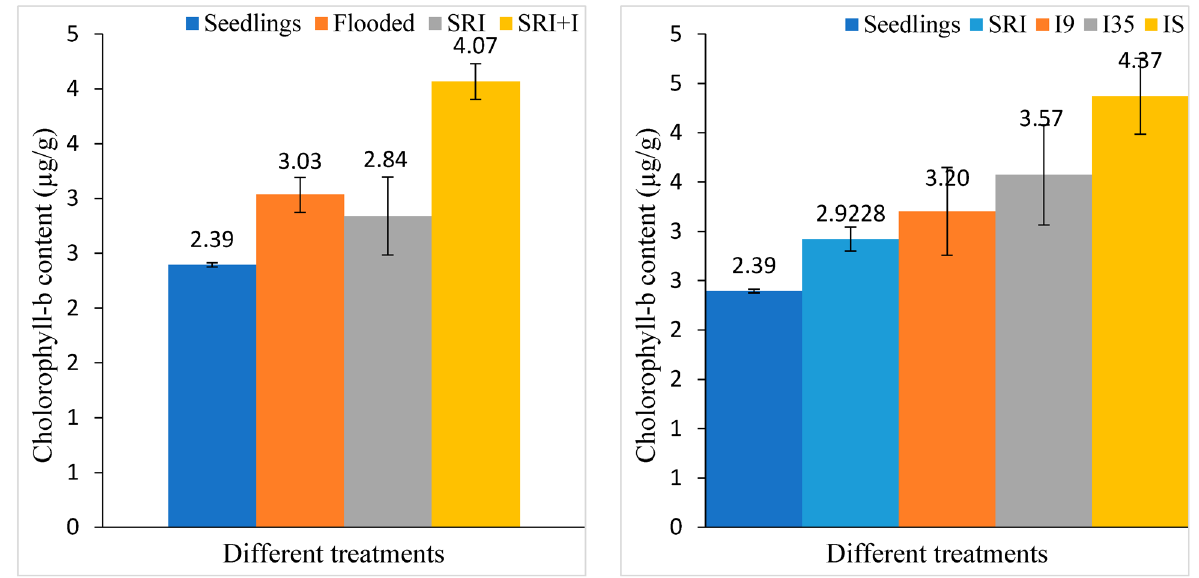
Figure 12. Comparison of chlorophyll-a content between the different treatments ( Left : 2017; Right : 2018).